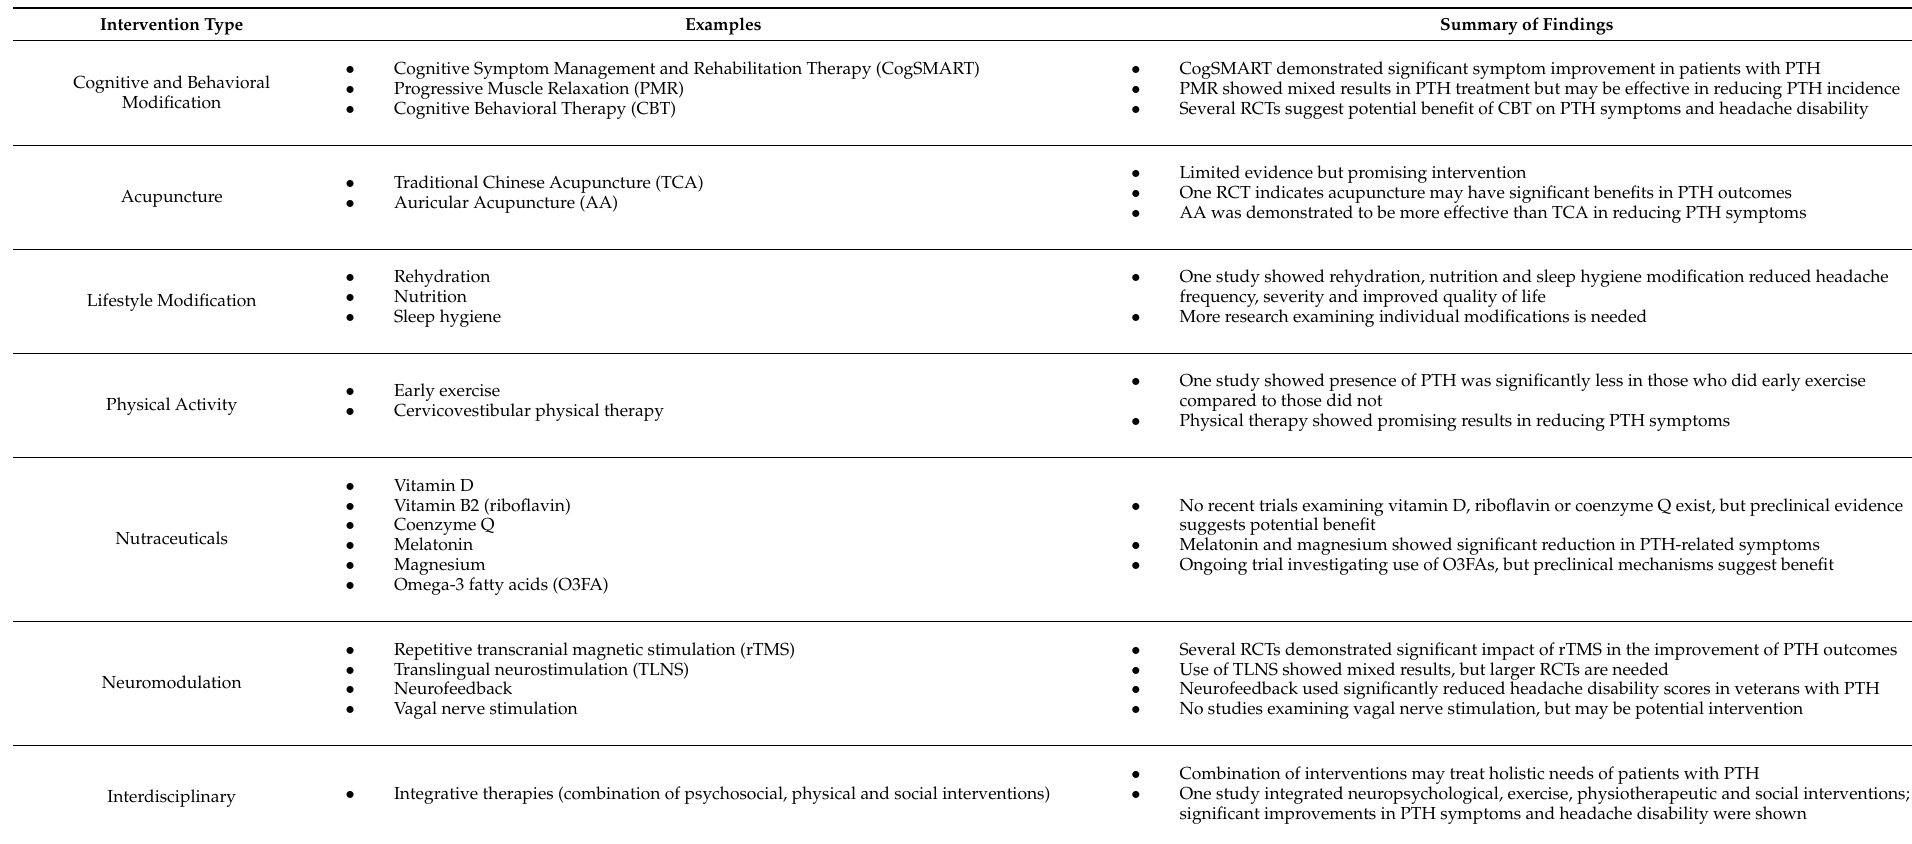
Table 1. Summary of types of non-pharmacological interventions used in management of